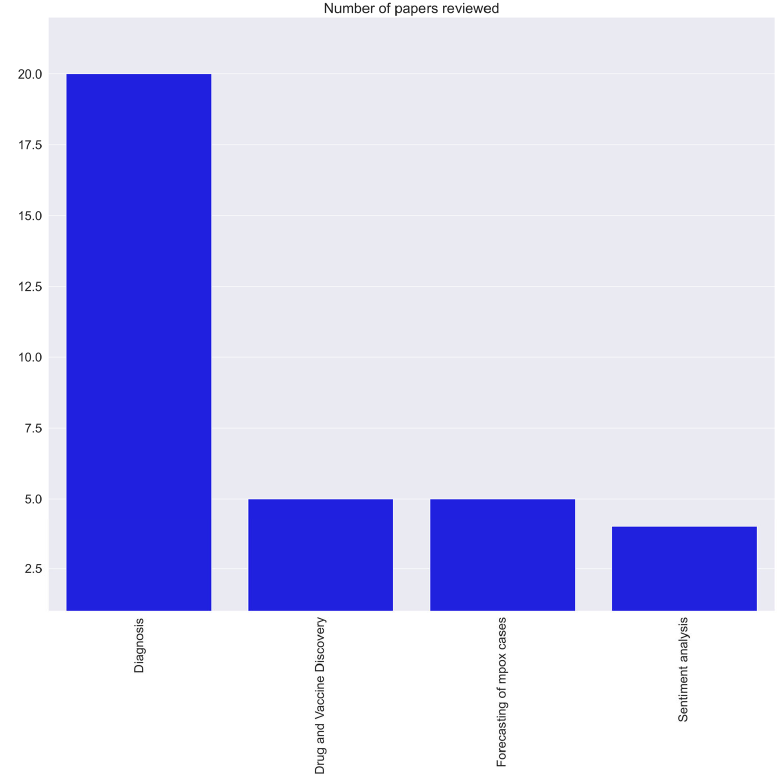
Figure 5. Articles selected in various categories related to mpox and